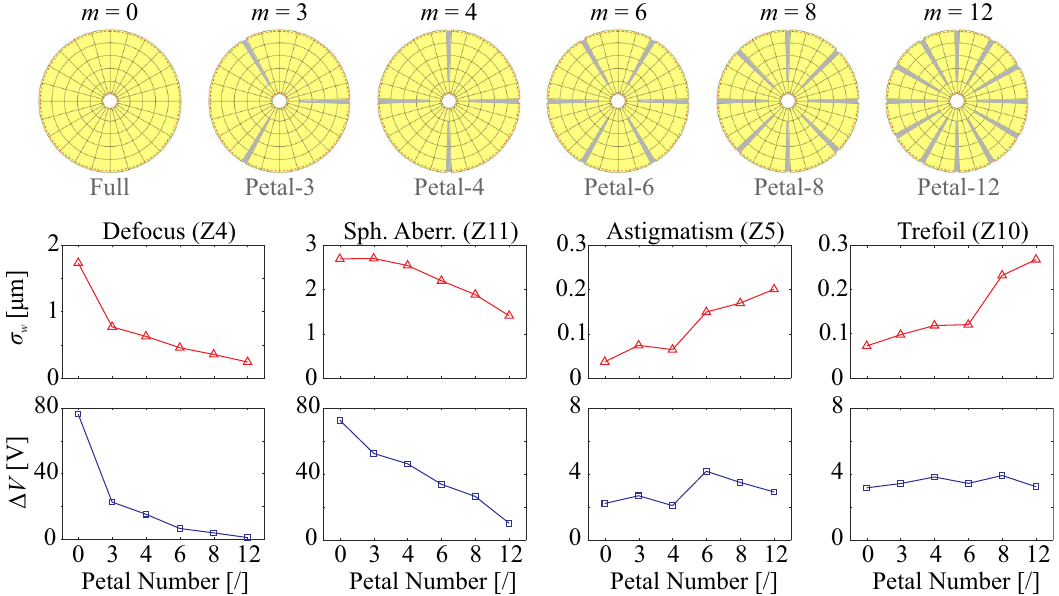
Figure 9. Performances of active surface control (the wavefront RMS error σ w and the voltage range ∆ V ) with different numbers m of petal segmentation. The electrodes are arranged with a keystone pattern of n R = 5 and n AZ = 24, and the amplitude of the target shape is PV = 10 µ